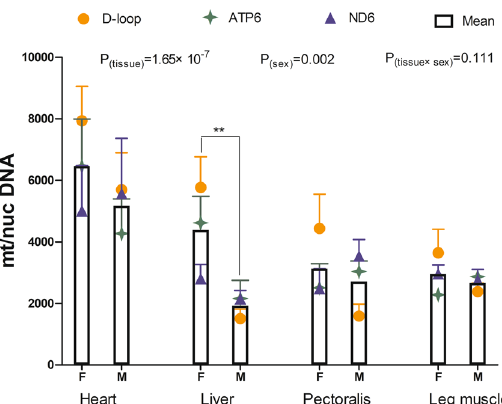
Figure 4. MtDNA copy number of male and female broilers. mt/nucDNA = mtDNA relative to nuclear DNA ( GCG ) copy number. The P values for sex and tissue determined by two-way ANOVA are presented in the figure. Comparisons between sexes in certain tissues were based on one-way ANOVA. ** Indicates P ≤ 0.01, and no * indicates P > 0.01. Abbreviations: F, female; M, male. n =